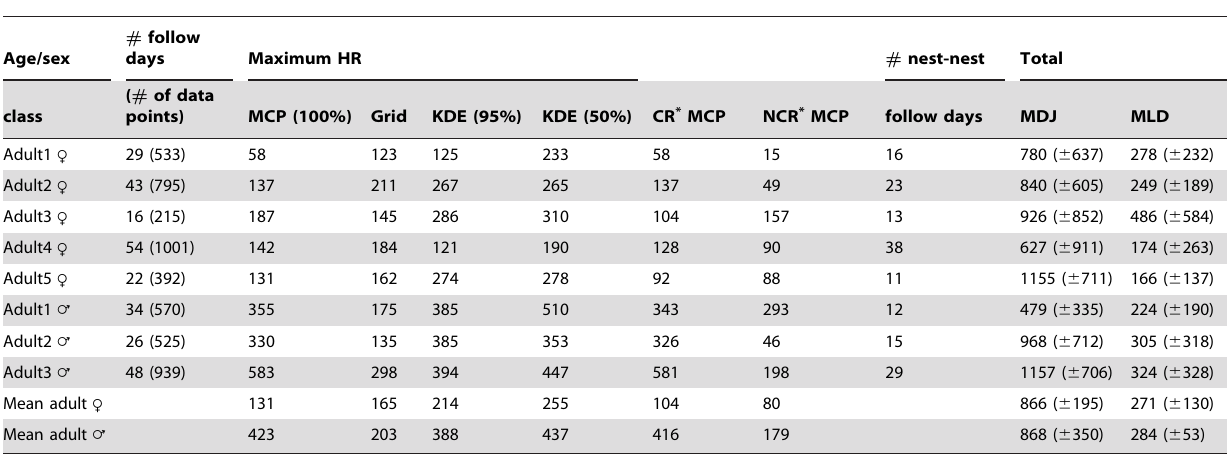
Table 2. Orangutan home range (HR) size estimates (in ha) during crop-raiding (CR) and non crop-raiding (NCR) periods using minimum convex polygon (MCP), 100 6 100 m grid-cell based and Kernel Density Estimation (KDE) methods, and mean